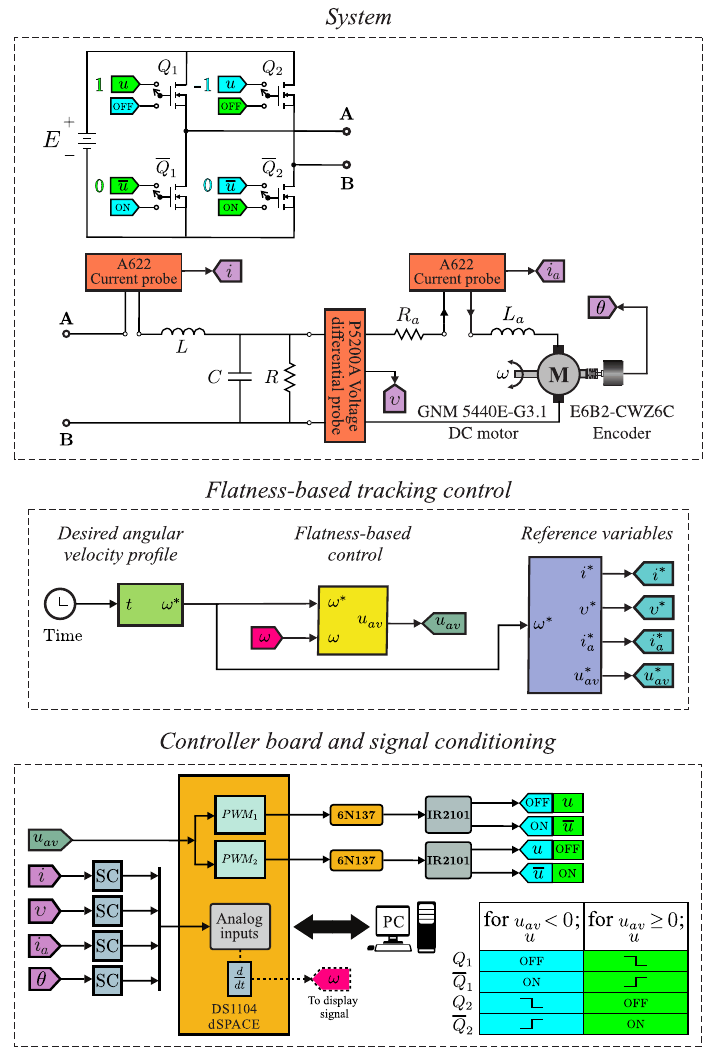
Figure 4. Connections between the software and hardware blocks of the built full-bridge Buck inverter–DC motor system in